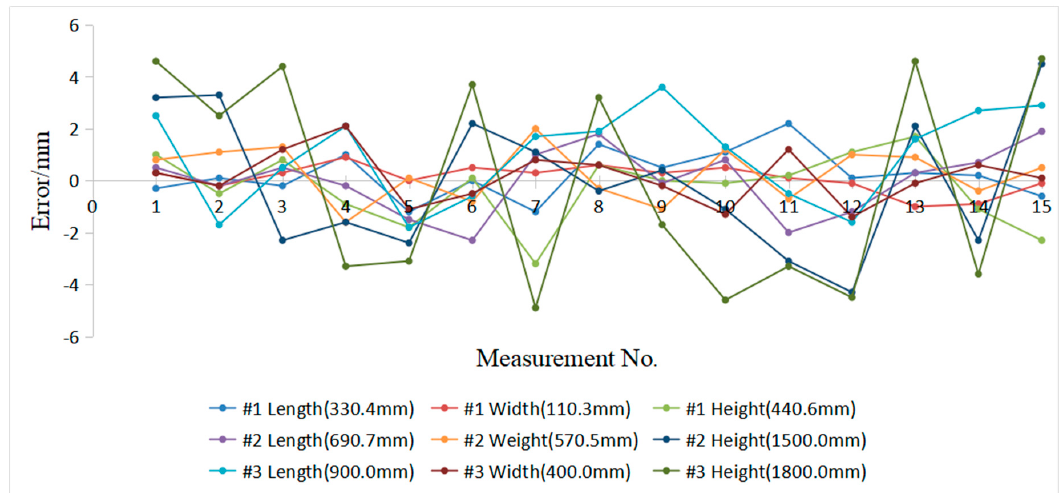
Figure 21. Errors between the standard box and the measured result.